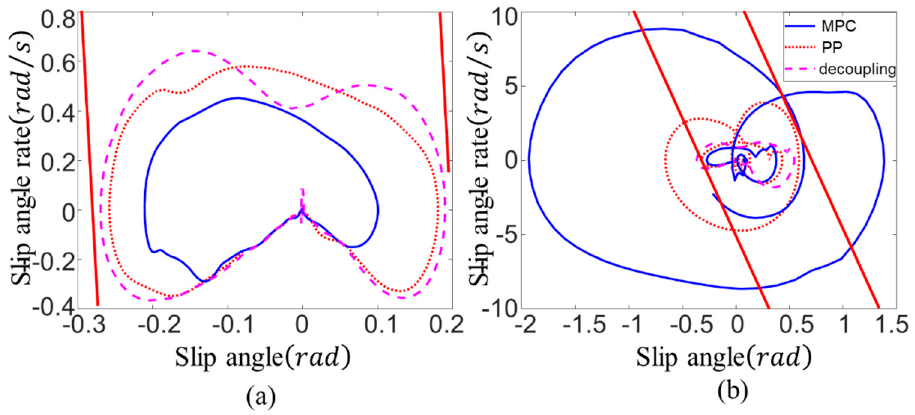
Figure 11. The sideslip phase-plane diagram: ( a ) steering with deceleration; ( b ) steering with acceleration.